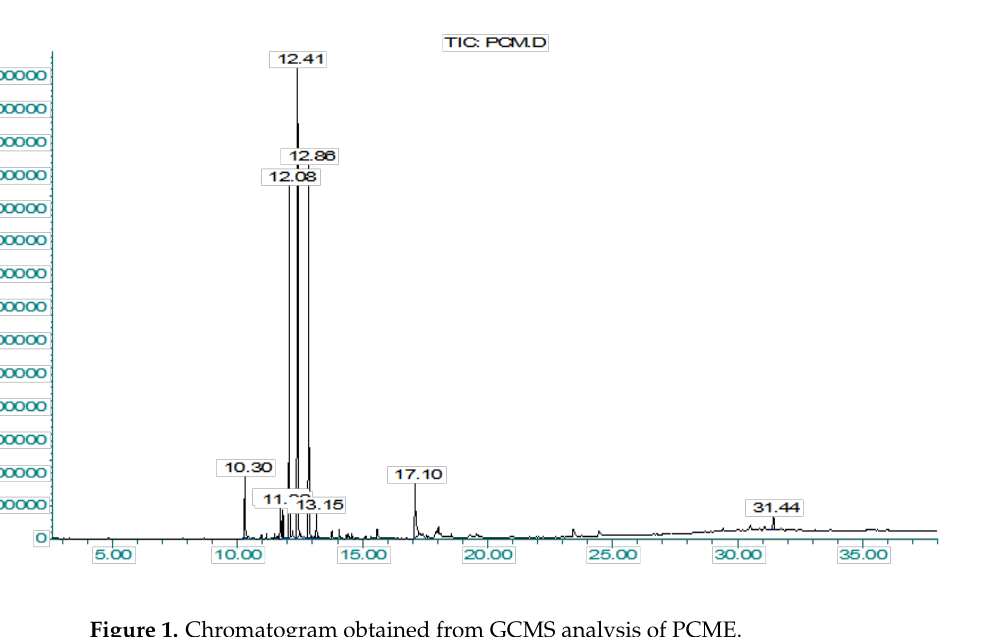
Figure 1. Chromatogram obtained from GCMS analysis of PCME. Table 2. Phytochemical profiling of methanolic extract (PCME) of P. candollei through GCMS anal- ysis.